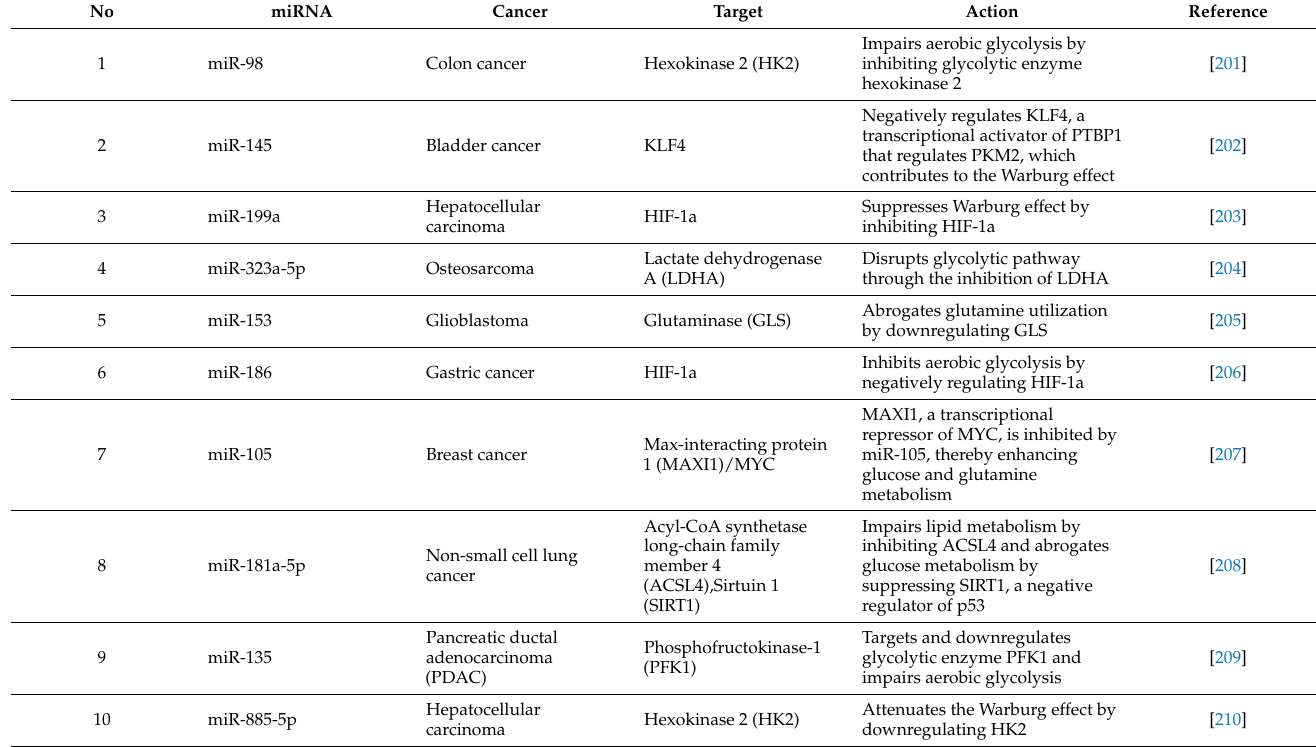
Table 9. The miRNAs implicated in metabolic